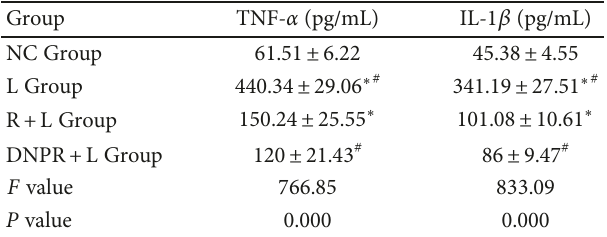
Table 2: E ff ects of LPS and LPS/CCR2 antagonist interventions on TNF- α and IL-1 β in LPS-induce ALI rat models by ELISA ( x ± s , n = 10 ).